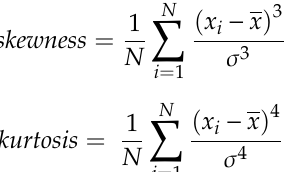
Figure 8. EN data in frequency domains for FB steels exposed in NaCl, CaCl 2 and MgCl 2 solutions.